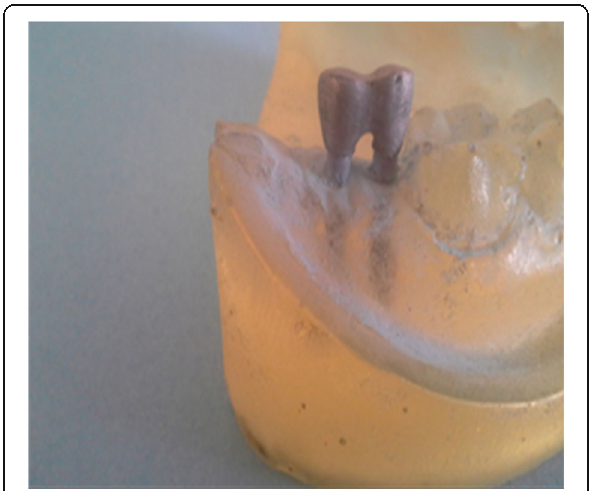
Fig. 2 Metal crown supported on two mini implants Fig. 3 Lava Ultimate Restorative crown on the two mini